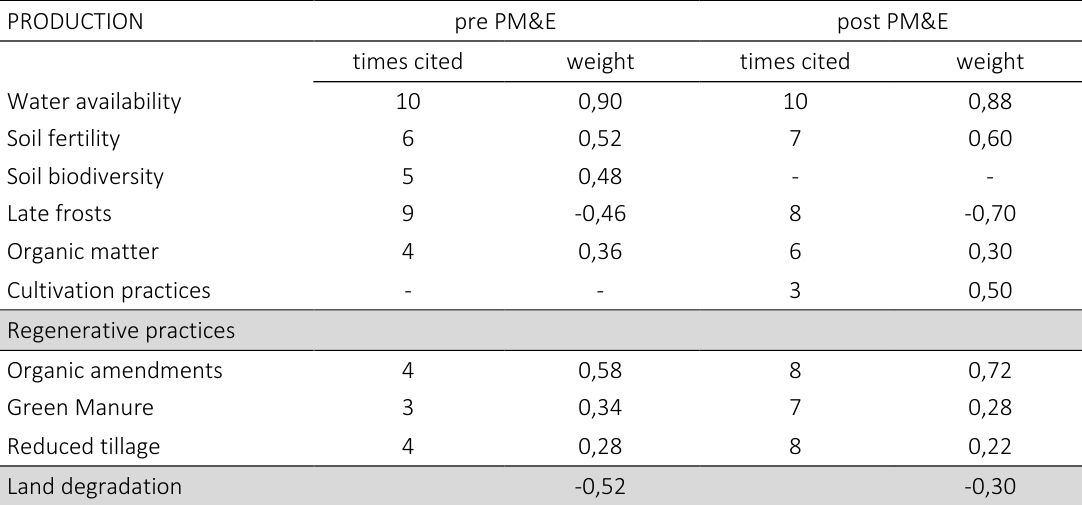
Table 2 Most cited factors and regenerative practices linked to production, times cited by participating farmers and strength of influence (weight) before and after